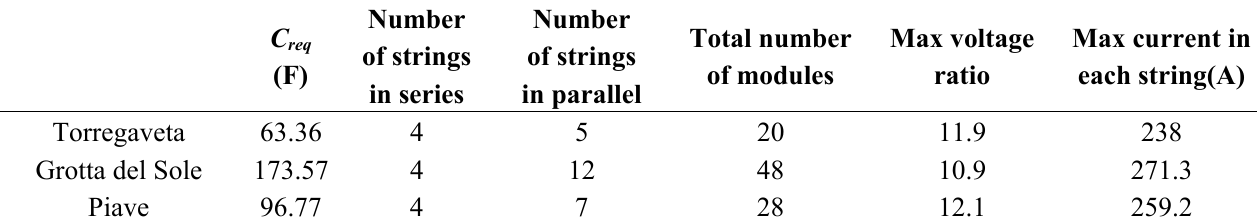
Table 6. Number of modules in each